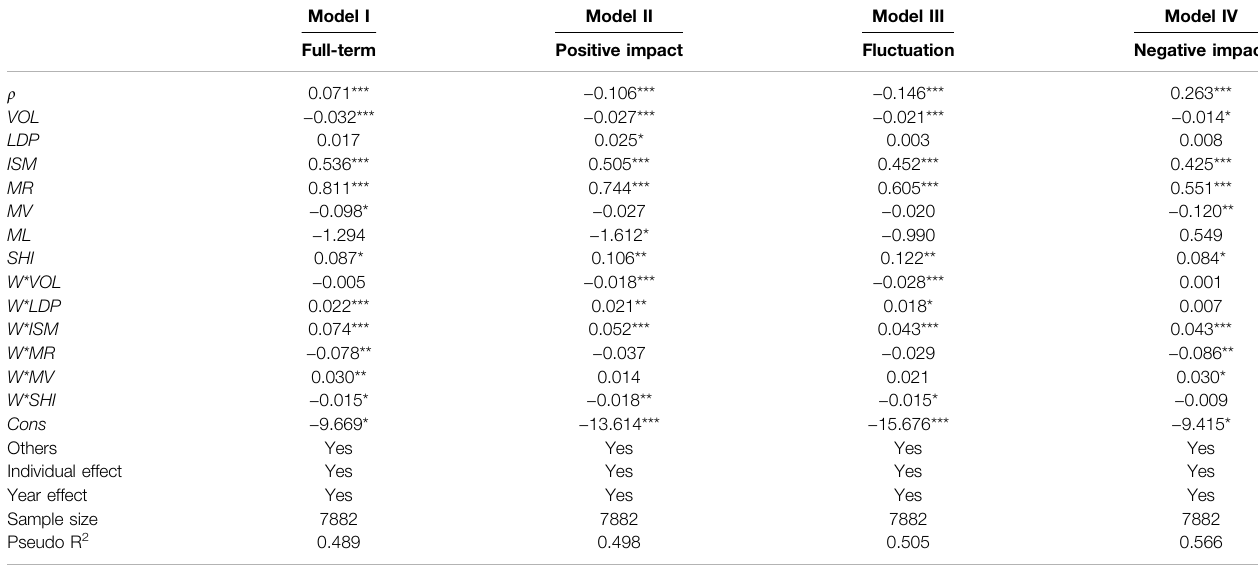
TABLE 9 | Results of SDQR under the MDMC